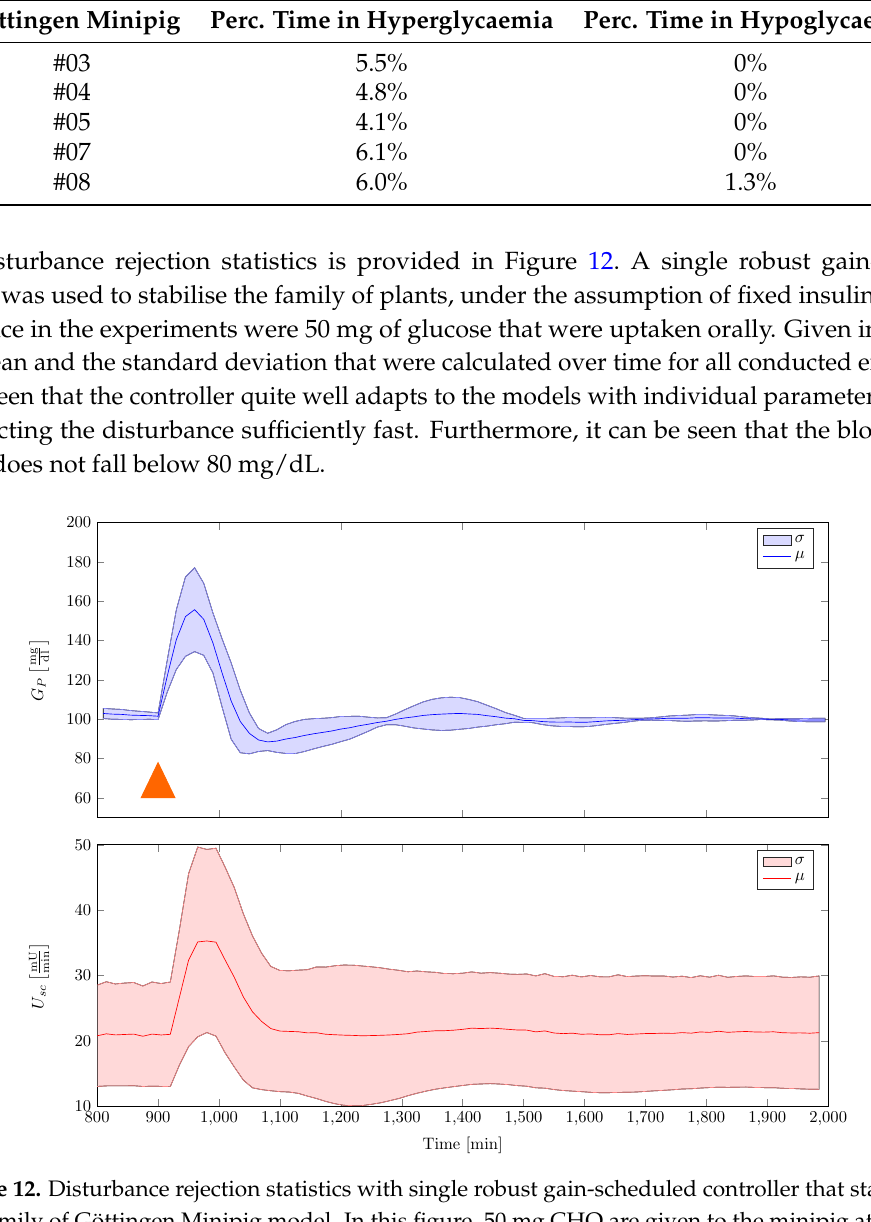
Table 1. Overview of achieved results for 36 h in silico trial with the robust controller (with percentage of time of the blood glucose concentation above 120 mg/dL or below 70 mg/dL).